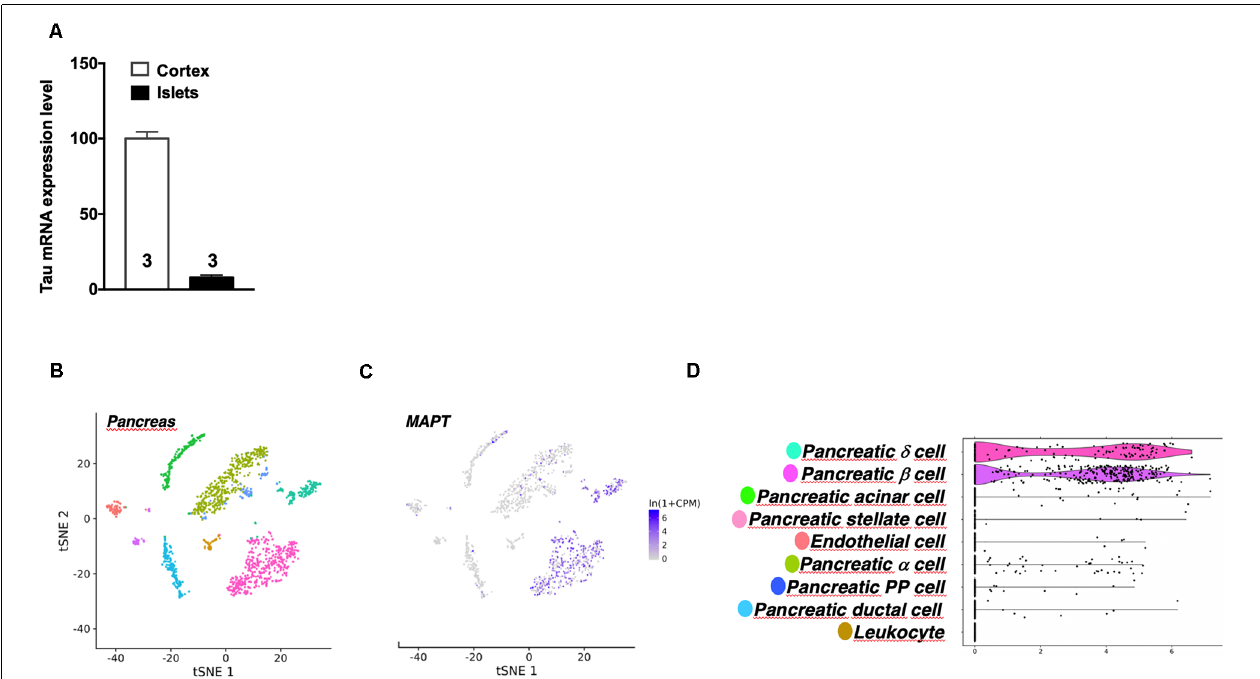
FIGURE 4 | Tau mRNA expression in mouse pancreas. (A) Tau mRNA expression in pancreatic islets and cortex of adult wild type mice (5 months). Tau mRNA expression in endocrine pancreatic islets represents 10% of its expression in the hippocampus. Results are expressed as mean ± SEM. (B) t-Distributed Stochastic Neighbor Embedding (t-SNE) visualization of all mouse pancreatic cells collected by fluorescence-activated cell sorting (FACS). (C) Single-cell transcriptomic data of Mapt gene from adult mouse pancreatic tissue. (D) Differential expression of Mapt gene between different mouse pancreatic islets cells. For images (B–D) data were extracted from the Tabula Moris single-cell RNA-sequencing